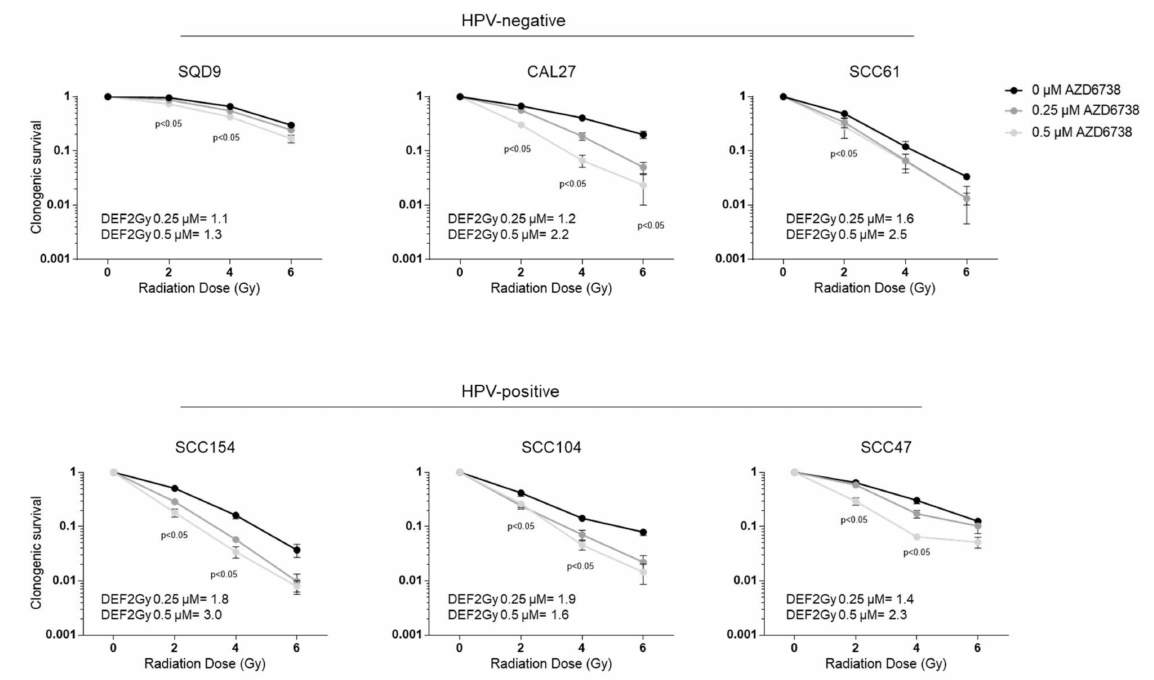
Figure 2. Effect of ATR inhibition on radiotherapy (RT) response of HPV-negative and HPV-positive head HNSCC cells. HPV-negative (SQD9, CAL27, and SCC61) and HPV-positive (SCC154, SCC104, and SCC47) cells pre-treated for 2 h with DMSO or AZD6738 were irradiated with the indicated RT doses. Clonogenic cell survival is shown as the mean clonogenic survival fraction ± s.e.m., n = 3. P -values were calculated with two-way ANOVA with Bonferroni correction for multiple testing. The dose enhancement factor at 2Gy (DEF2Gy) is defined as the ratio of average survival at 2Gy of the control samples divided by the average survival at 2Gy of 0.25 or 0.5 µ M treated